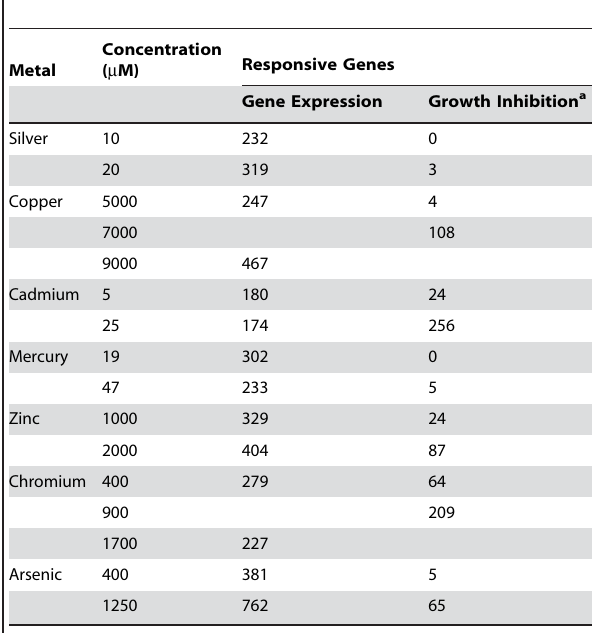
Table 1. Summary of Differentially Expressed Genes and Metal-Sensitive